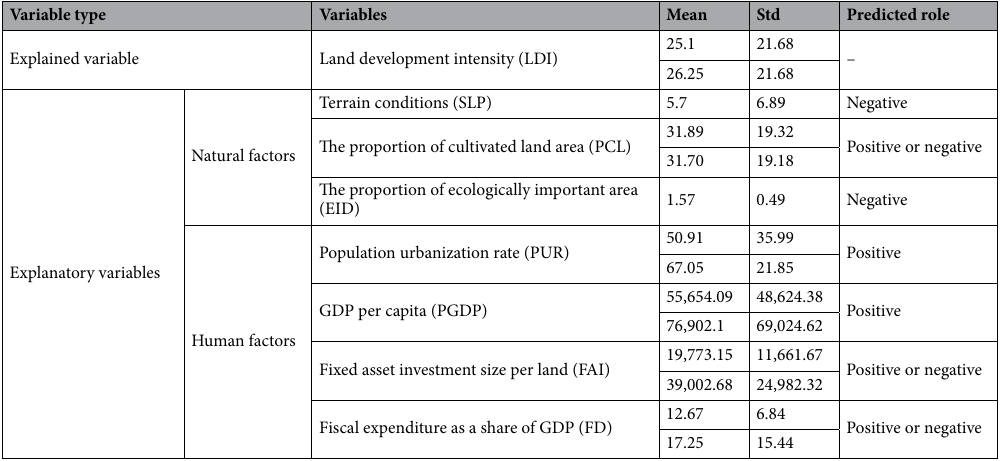
Table 1. Descriptive statistics of main